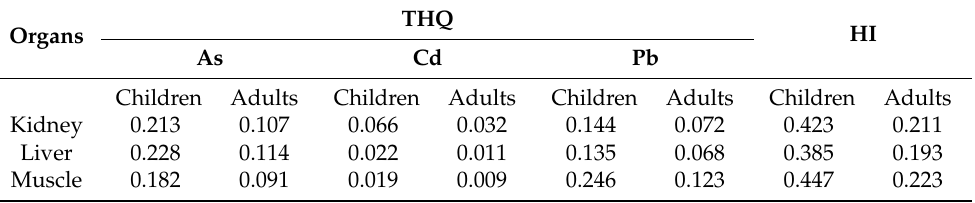
Table 8. Target hazard quotient (THQ) and hazard index (HI) specific to children and adult consumers of goat carcass processed in Enugu State,